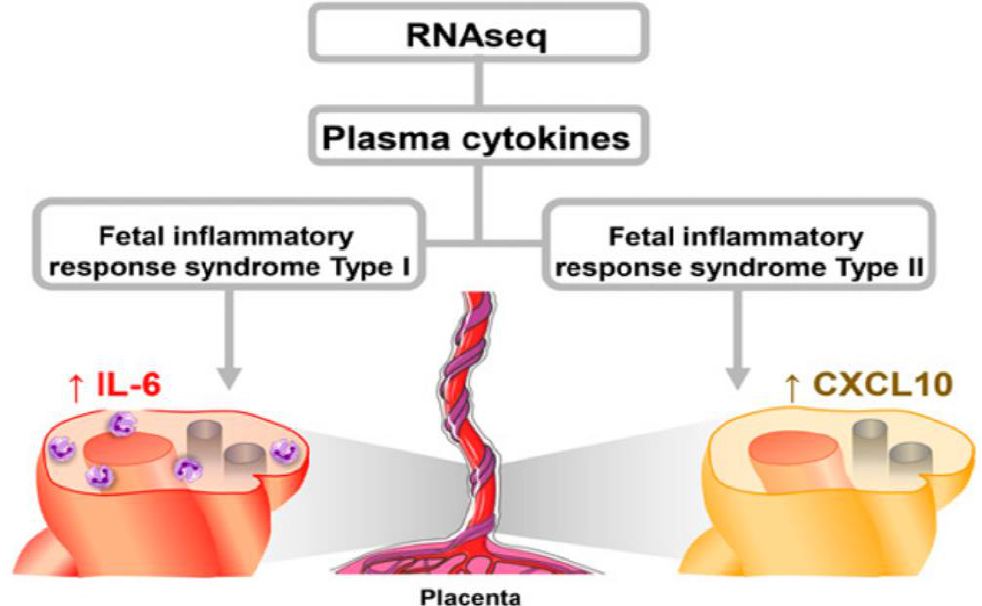
Figure 4. Two types of fetal inflammatory response have been described based on statistical analyses comparing the results of RNA sequencing from human cord blood samples of preterm neonates diagnosed with fetal inflammatory response syndromes type I and type II after birth associated with placental-cord histopathological findings. Placental examinations were performed by pathologists blinded to the clinical histories. FIRS type I was characterized by an upregulation of host immune responses, including neutrophil and monocyte functions, together with a proinflammatory cytokine storm and a downregulation of T cell processes. IL 6 was the representative cytokine that was excessively released. This process was correlated with acute and chronic lesions of chorioamnionitis and funisitis. In contrast, FIRS type II comprised a mild chronic inflammatory response involving perturbation of HLA transcripts, suggestive of fetal semi-allograft rejection. CXCL 10 was the representative chemokine that was excessively released. This process was depicted by findings of chronic chorioamnionitis, villitis or deciduitis. Abbreviations: IL 6, interleukin 6; CXCL 10, chemokine 10 [27].